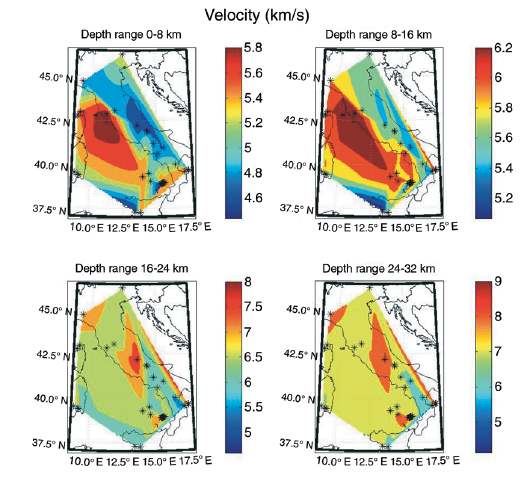
Fig. 9. Contour maps of mean velocities in four classes of depth, relative to constant gradient models. The stars represent the centres of the profiles which the 1D model is relative